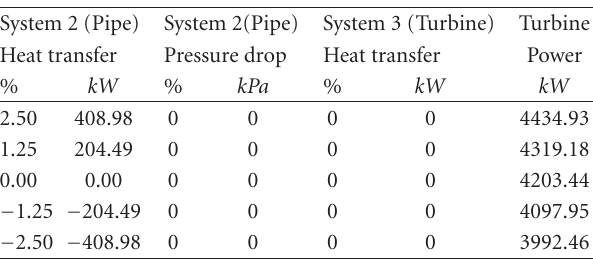
Table 4: Numerical results for 1 DOF 1st law analysis.